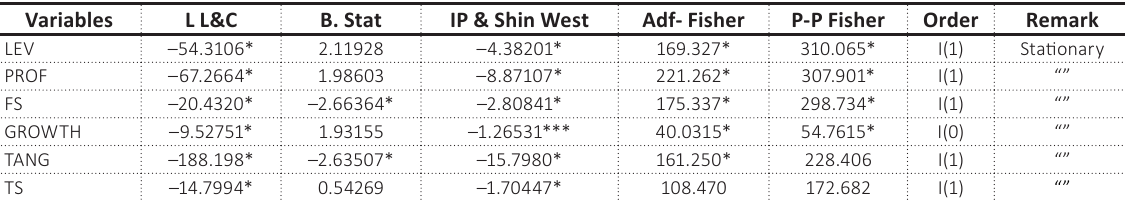
Table A4. Group panel unit root test